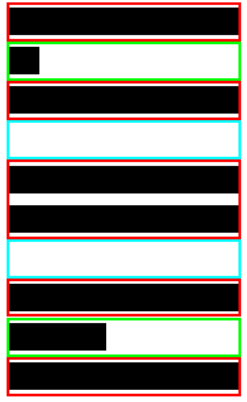
Figure 11. Different distributions of characters and blanks in area 2.